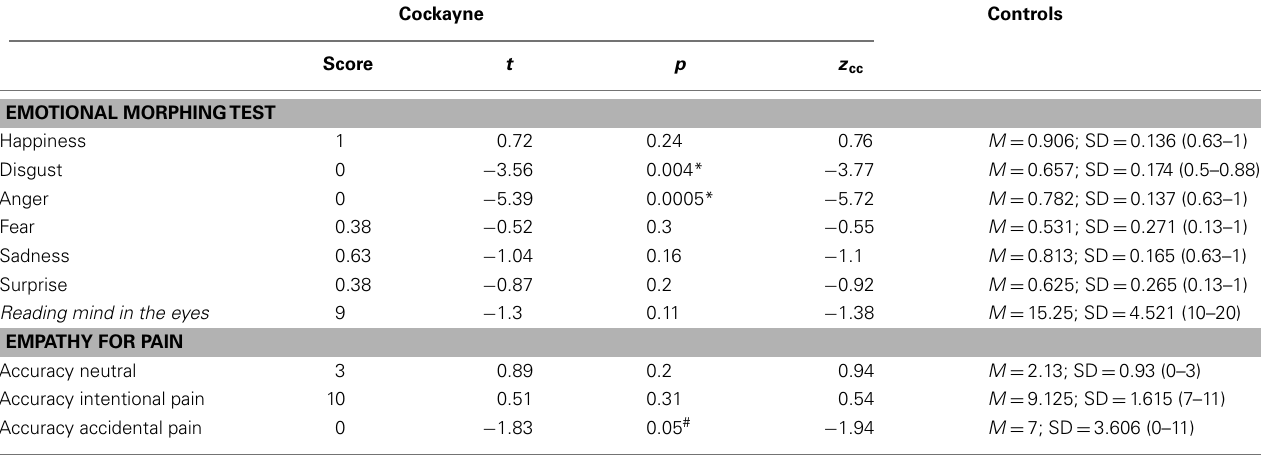
Table 2 | Social cognition tasks